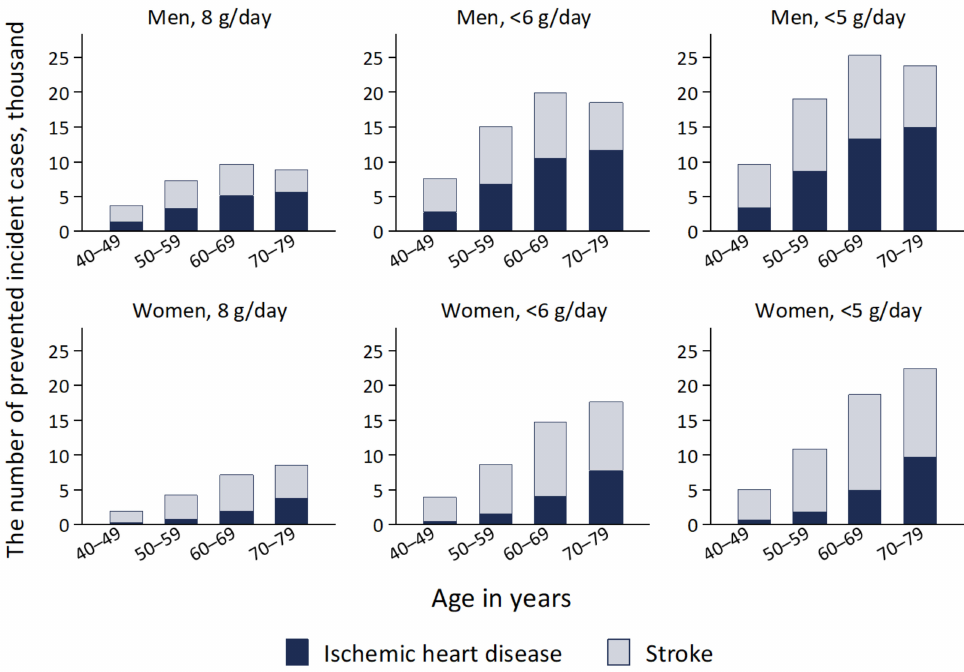
Figure 2. Projected cumulative totals of incident cases from ischemic heart disease and stroke prevented by reducing mean dietary salt intake to 8 g/day, <6 g/day, and <5 g/day between the years 2019 and 2029 in a closed cohort of population aged 40–79 years in 2019.